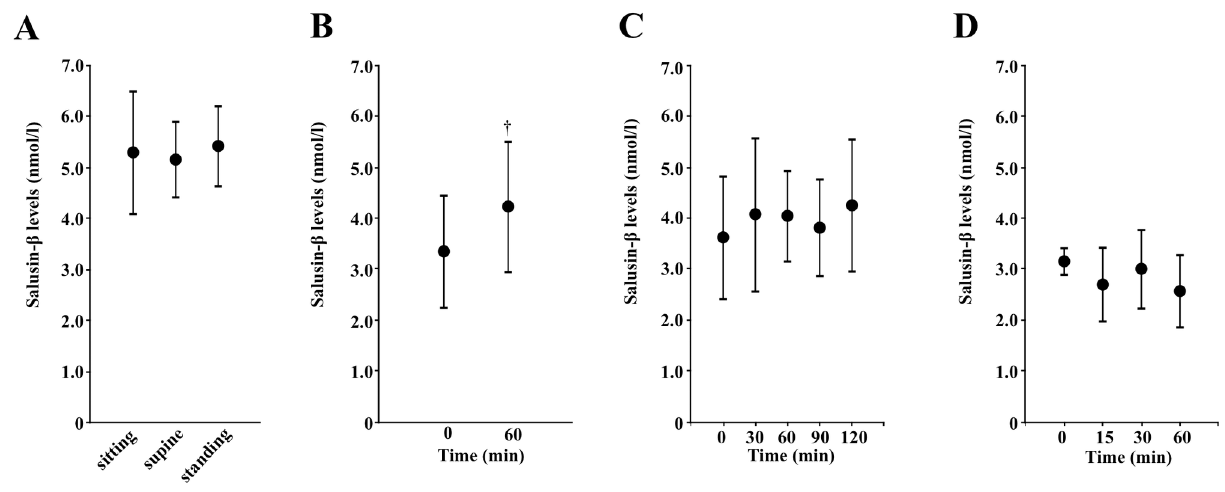
Figure 4. Effects of postural changes, oral water load, osmotic stimuli, and smoking on plasma salusin-β concentrations. A . Seven healthy subjects sat on a chair for 15 min, lay supine for the following 30 min, and then either kept standing or walking for a final 60 min. A blood sample was taken at the end of the sitting, supine, and standing periods for the measurement of plasma salusin-β levels. B . Nine healthy volunteers given an oral water load of 20 ml/kg body weight within 20 min had blood sampling before and 1 h after for the measurement of plasma salusin-β levels. C . Six healthy subjects were given hypertonic saline intravenously, and blood was drawn before and 30, 60, 90, and 120 min after the start of the infusion for the measurement of salusin-β. D . Six current male smokers smoked one filtered cigarette containing 0.6 mg of nicotine within 4 min. Blood samples were collected before and 15, 30, and 60 min after the initiation of smoking for the measurement of salusin-β. Data points with bars represent mean ± SD. * P < 0.05 vs. baseline value.